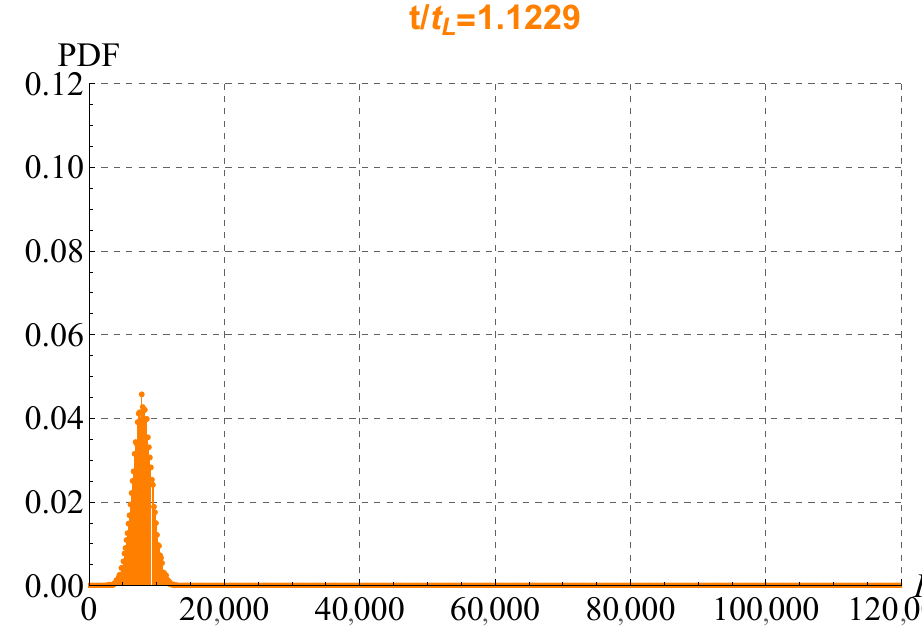
Figure 8. Probability density function (PDF), solution of Equation (36) for Italy, first wave of infection by SARS-CoV-2. Screenshoot at time ˆ t = 1.129. The values of the parameters are I 0 = 5000, K = 150,000, α = 1.5, and β = 0.1, respectively.